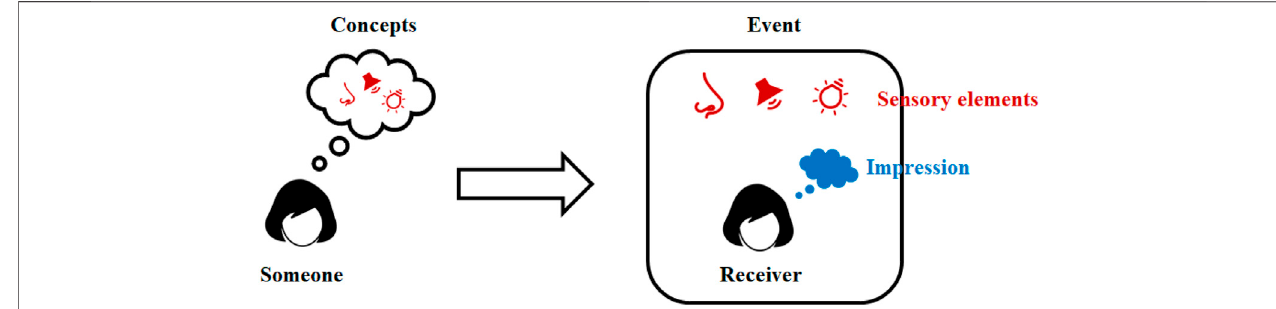
FIGURE 1 | Schematic representation of our de fi nition of multisensory experiences. Multisensory experiences (right of the arrow) are impressions formed by speci fi cevents (black square), whose sensory elements (in this case represented by smell, sound, and light, in red) have been carefully crafted by someone (left side of thearrow) foragivenreceiver,capitalizingonconceptsofmultisensoryperception(inthecloud).Notethat,whilstmostofpeople ’ sexperiencesaremultisensoryperse, multisensory experiences are different in that there is intentionality in them. In other words, while, say, walking in a forest or jungle (event) involves a number of sensoryelements,amultisensoryexperience,asweputforward,iscarefullydesignedbysomeone.Take,asanexample,awalkinthejunglethathasbeendesignedbya landscape architect to evoke speci fi c impressions in a given receiver. Hence, when one refers to multisensory experiences, the “ design ” part is implied. For this same reason, multisensory experiences and multisensory experience design are often used